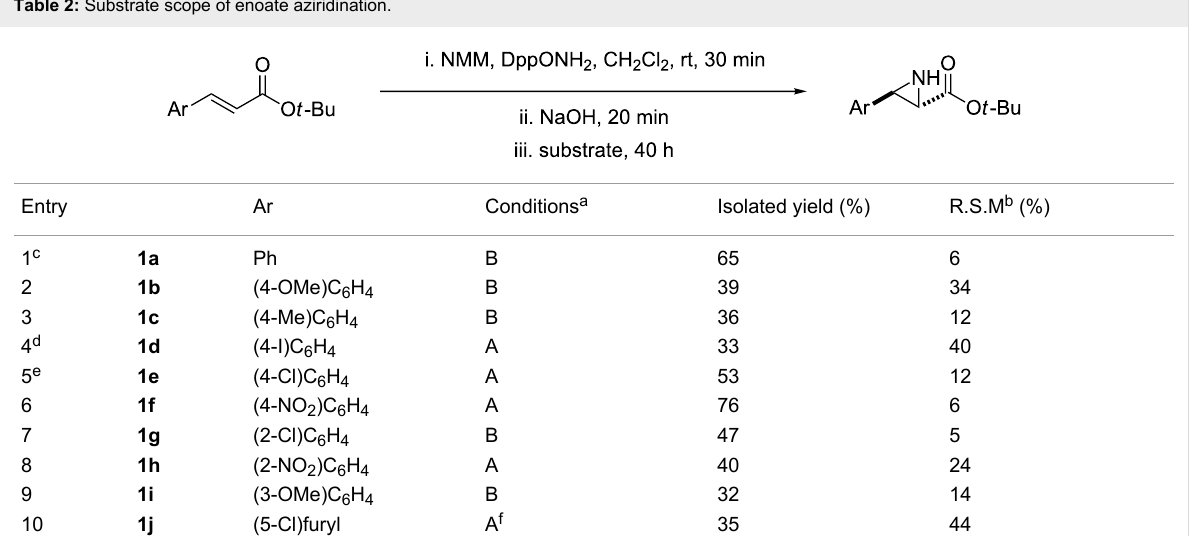
Table 2: Substrate scope of enoate